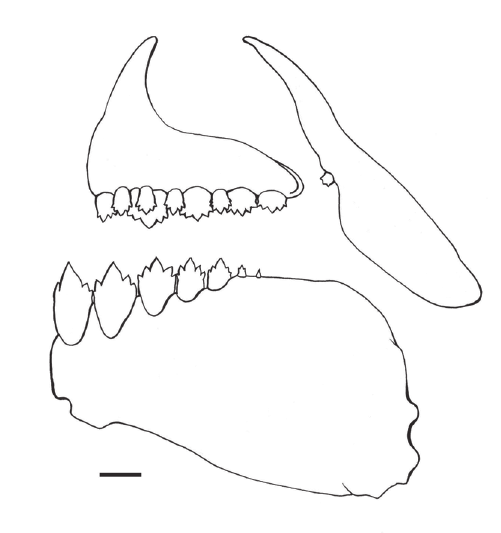
Fig. 2. Astyanax guaricana , MHNCI 5170, paratype, 69.0 mm SL, premaxillary, maxillary and dentary bones, left side, lateral view. Scale bar = 1